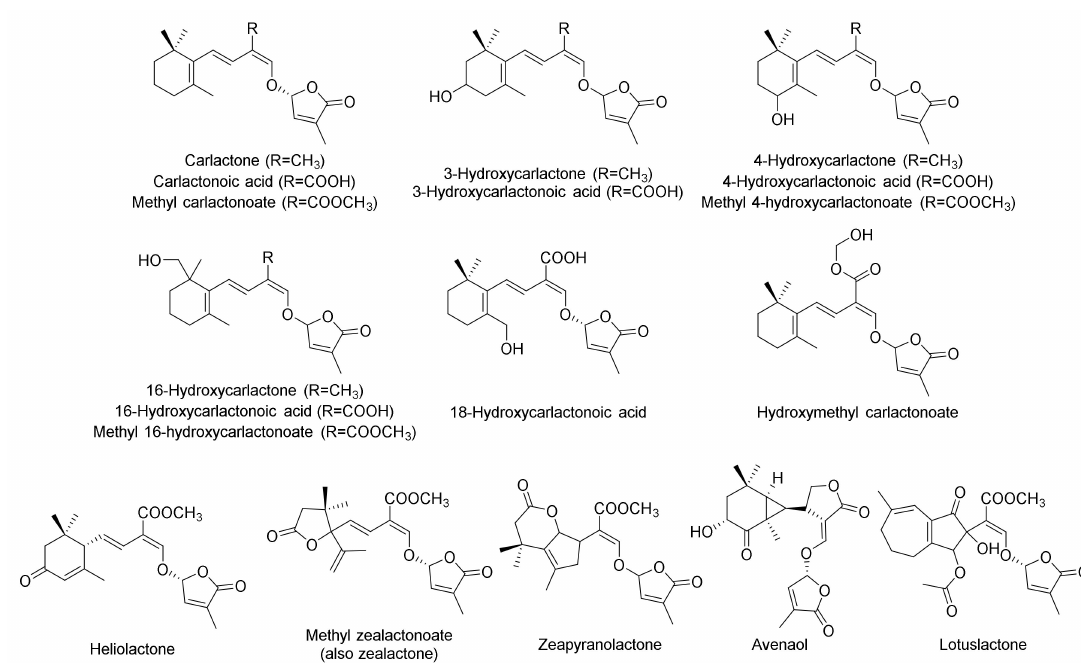
Figure 2. Non-canonical